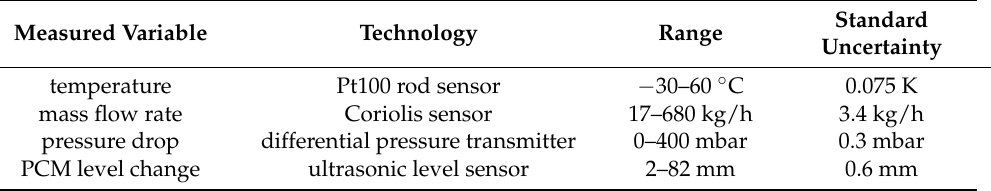
Table 4. Installed sensors and standard uncertainties with a rectangular